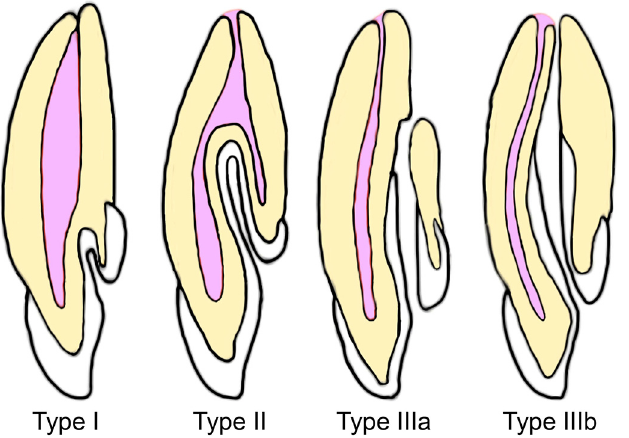
Fig. 1. The different types of dens invaginatus (Oehlers ’ classi fi ca- tion). According to Dr. Gambiez ’ s diagram.